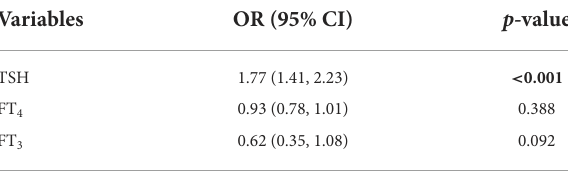
TABLE 3 A multiple stepwise logistic regression to identify independent factors of RLS.